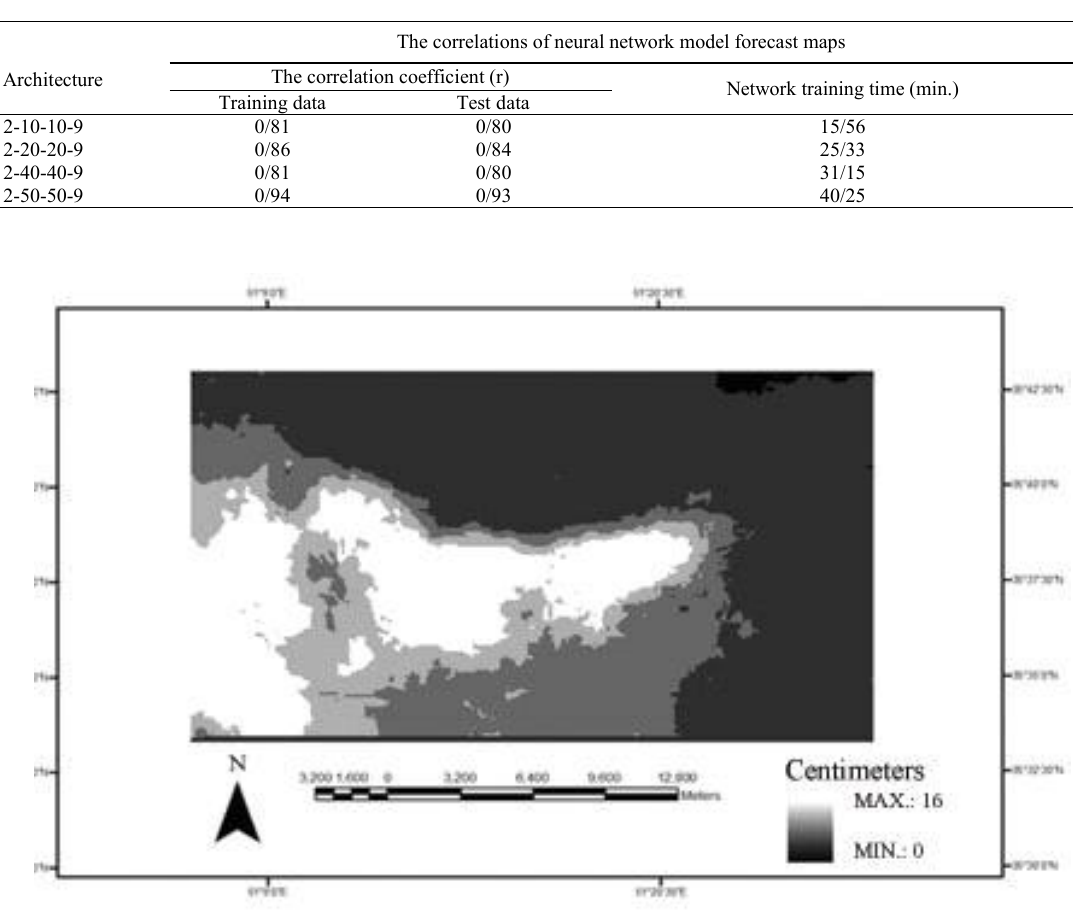
Fig. 6: Spectral map of implementation of the model